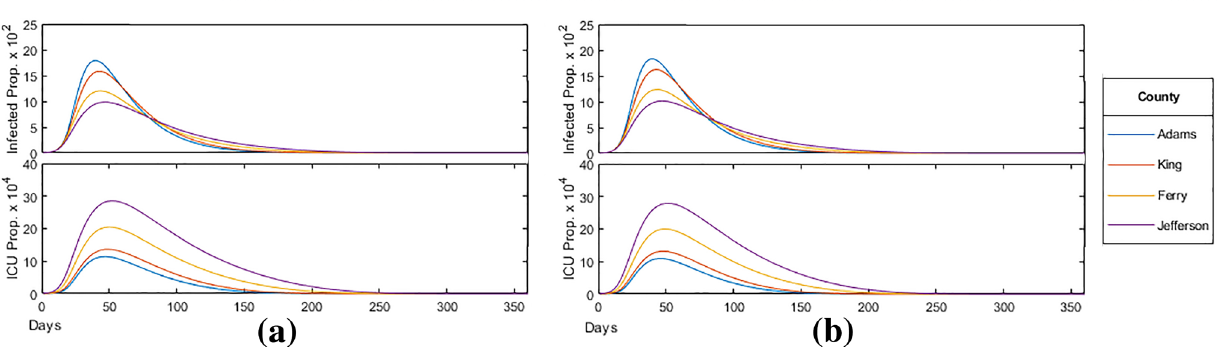
Figure 15. ( a ) Relative weights of vaccine distribution; ( b ) ge-targeted vaccine distribution statistics.